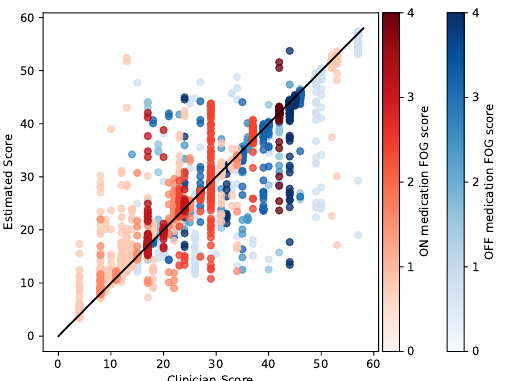
Figure 3. Scatter plot comparing clinician-rated versus model-estimated MDS-UPDRS-III total score, excluding the FOG item (3.11). Unity line is shown for reference. Each dot represents a single 4 s analysis window. Colors are used to represent the FOG item scores corresponding to each analysis window, with darker colors indicating more severe FOG in the OFF (blue) and ON (red) medication